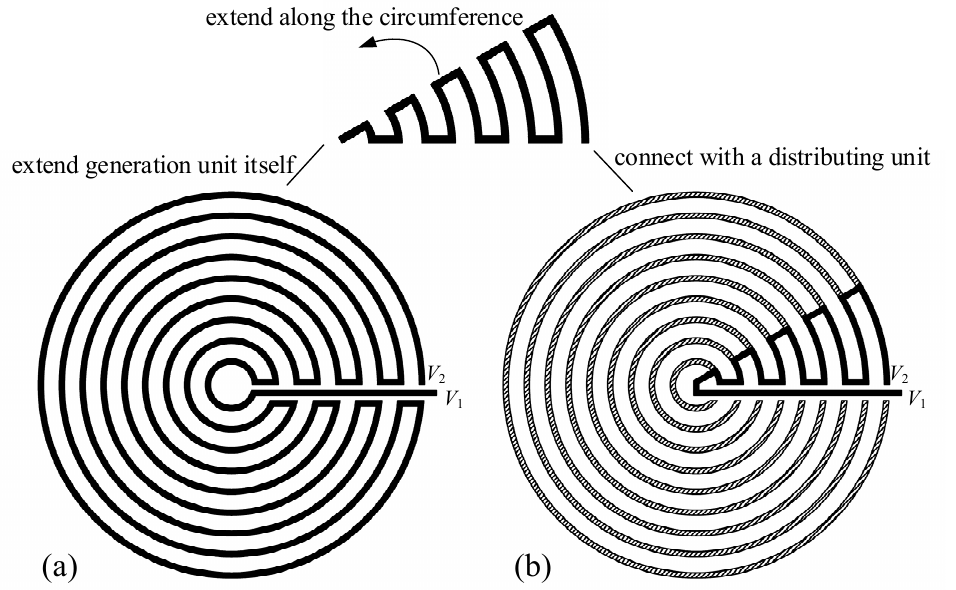
Figure 4. Two kinds of electrode patterns of a circular LC lens extended from the fan-shaped generating unit: ( a ) extend the resistance line of the generating unit itself, or ( b ) connect with a distributing unit.